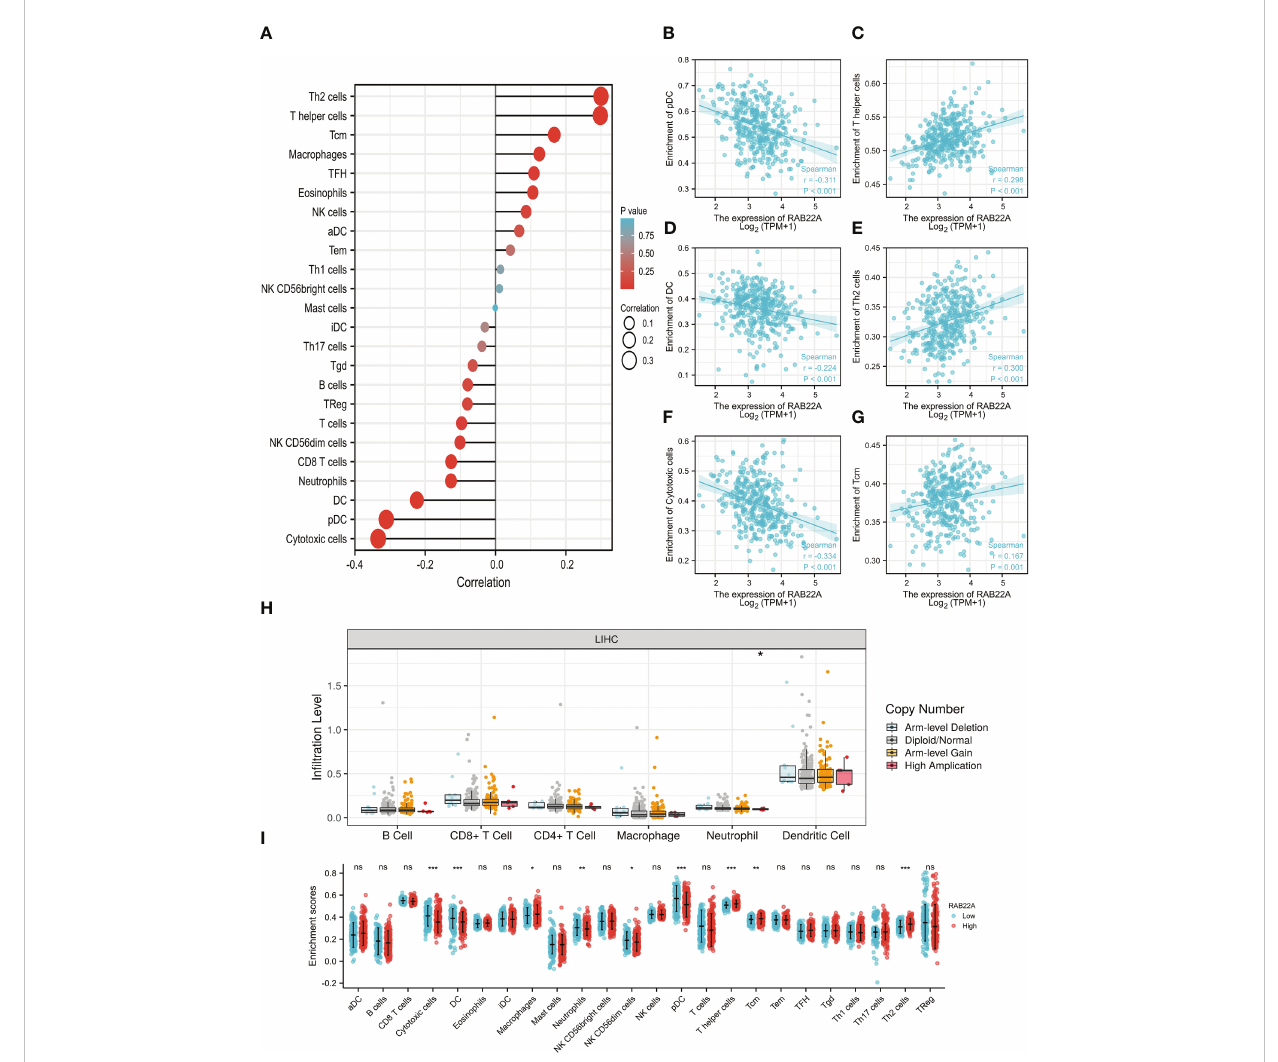
FIGURE 8 Relationship between the expression of RAB22A and microenvironment of immune in fi ltrating cells in HCC. (A) Forest plot depicting the relationship between RAB22A expression levels and the relative abundance of the 24 immune cells. (B – G) Scatter plots showing the degree of differentiation of pDCs, T helper cells, DCs, Th2 cells, cytotoxic cells, and Tcm cells between the high and low RAB22A expression groups. (H) SCNA showed that the expression of RAB22A correlated with the degree of immune cell in fi ltration. (I) Scatter plot showing the correlation of 24 immune cells with RAB22A expression levels. *p < 0.05, ** p < 0.01, *** p < 0.001, NS, no signi fi